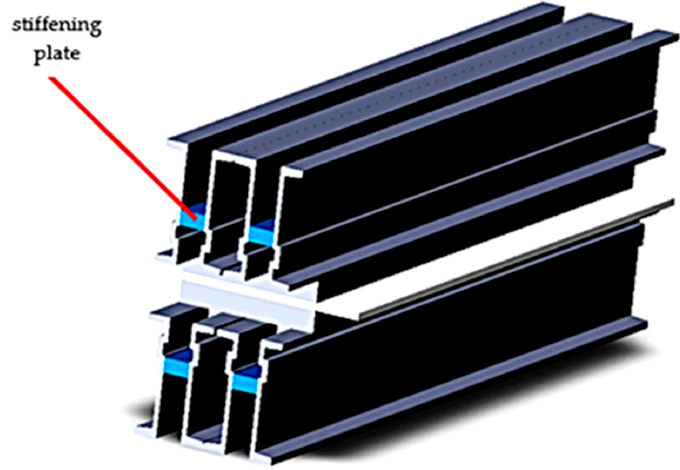
Figure 13. Belt vulcanization press with additional stiffening.